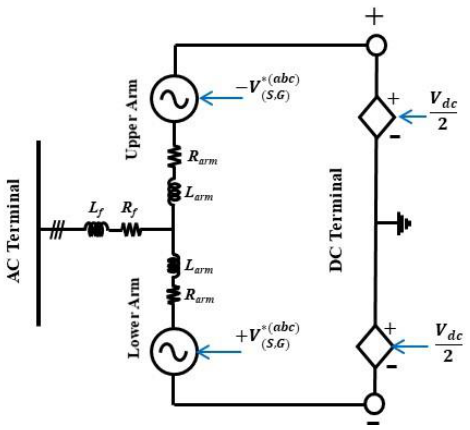
Figure 15. Simplified MMC circuit model.